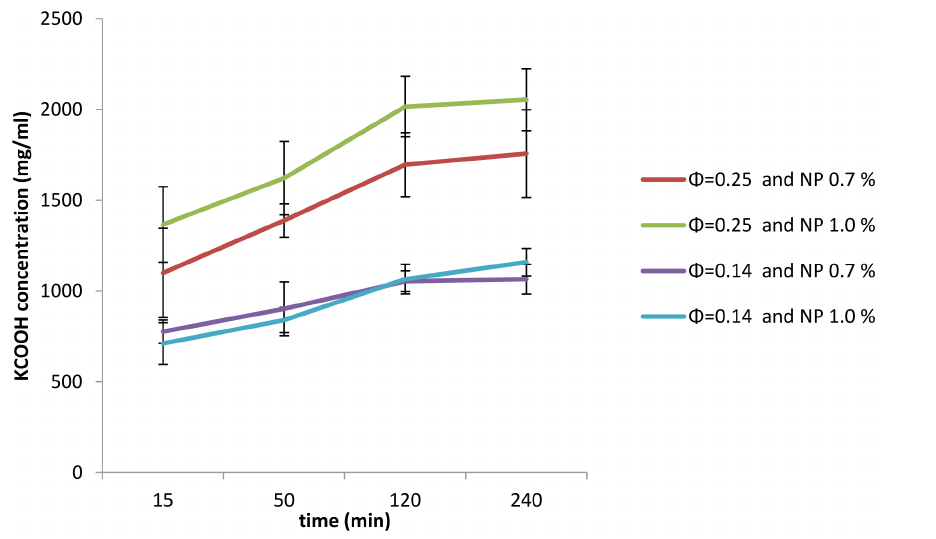
Figure 8. Effect of internal phase volume fraction and nanoparticle concentration on profile of potassium formate release from dry composite membranes with gelation of the internal phase. Data indicates the average of at least three observations with corresponding standard deviations.